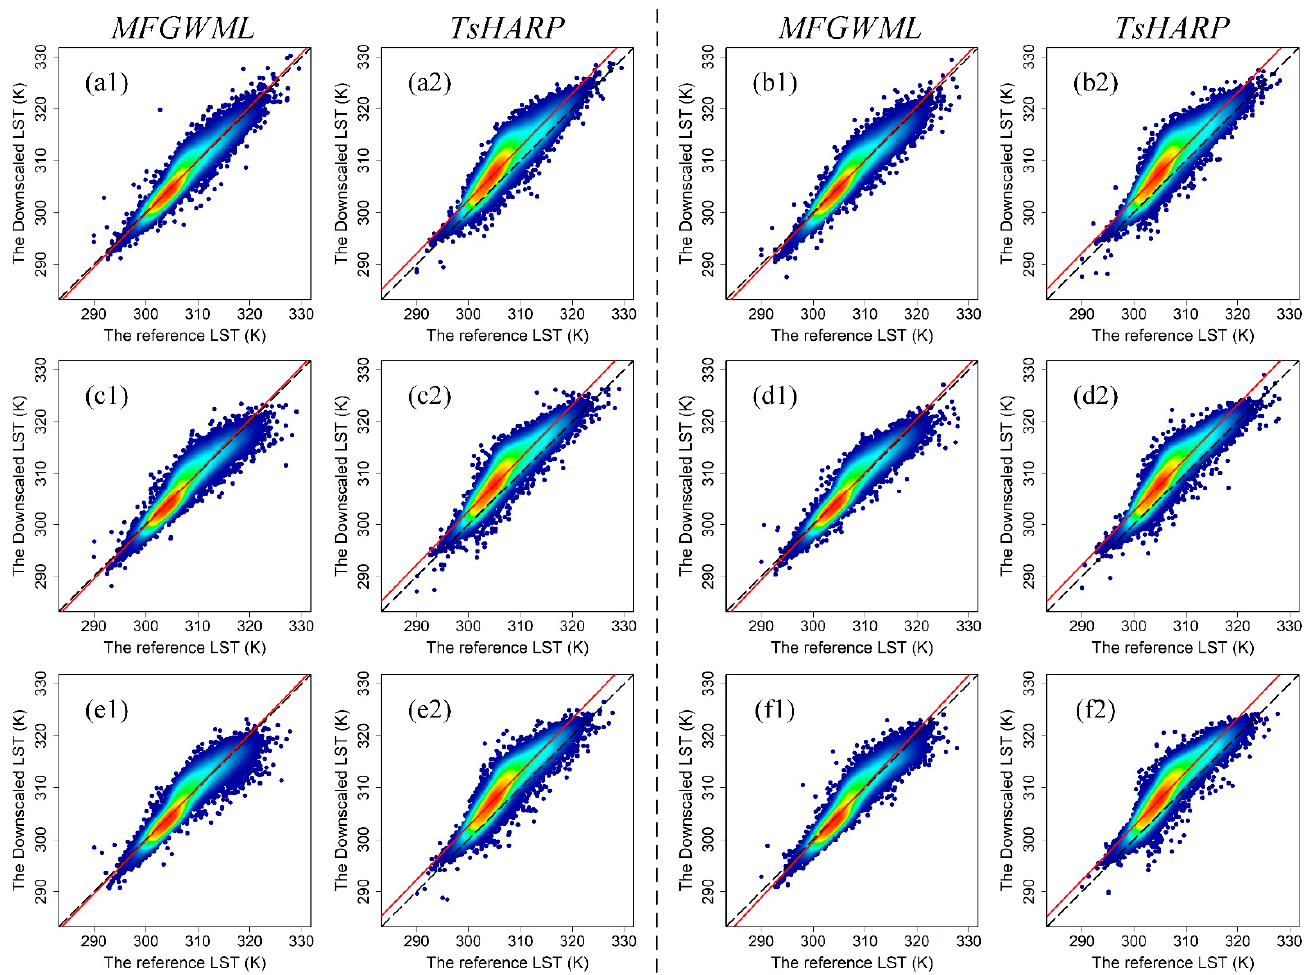
Figure 7. Pixel-based density scatterplots of the downscaled LST (K) data ( Y -axis) and reference LST (K) data ( X -axis) for the six downscaling schemes: ( a1 , a2 , b1 , b2 , c1 , c2 , d1 , d2 , e1 , e2 , f1 , f2 ). Plots ( a1 , a2 ) are the density scatterplots for Scheme 1, which corresponds to the MFGWML model and TsHARP model, respectively. The remainder of the plots are named in the same manner. The dotted black line is the 1:1 reference line, and the solid red line is the fitting line. Table 6. Statistical parameters of the fitting lines for scatters in MFGWML and TsHARP for the six downscaling schemes performed in the entire Beijing (excluding water regions).